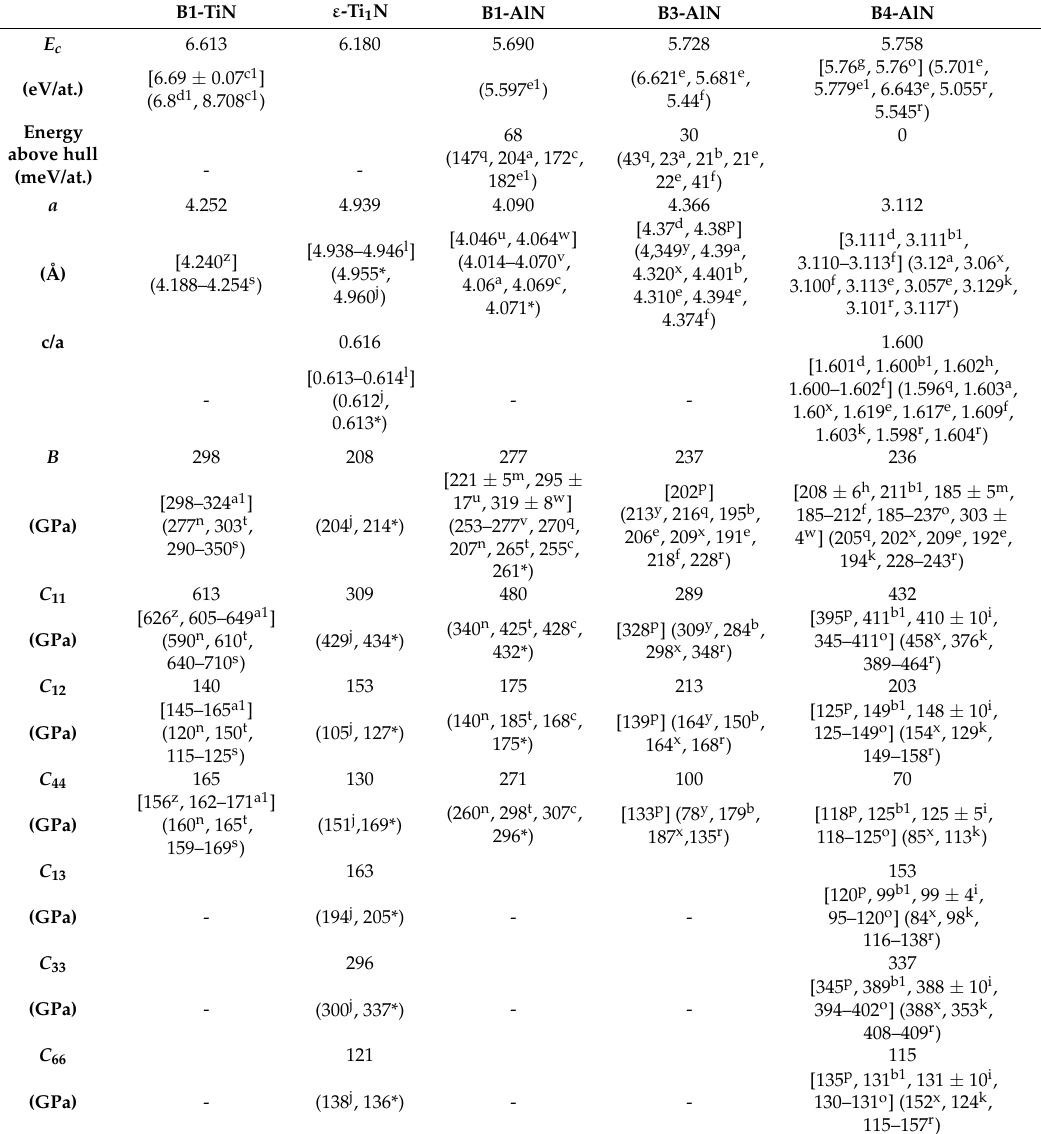
Table 1. MEAM-predicted cohesive energies ( E c ), lattice constants (a, c), and elastic constants ( B , C ij ) for B1-TiN, ε -Ti 2 N, B1-AlN, B3-AlN, and B4-AlN. Experimental and DFT values are listed in brackets and parenthesis, respectively.